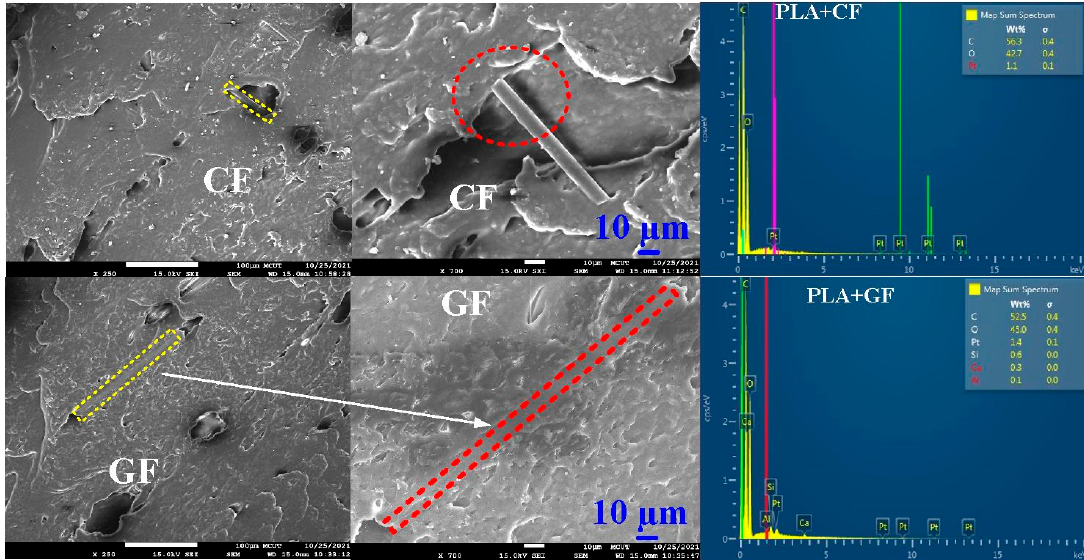
Figure 6. FE-SEM micrographs and chemical compositions of PLA filled with 10 wt.% GF reinforced PLA filled with 10 wt.% CF.